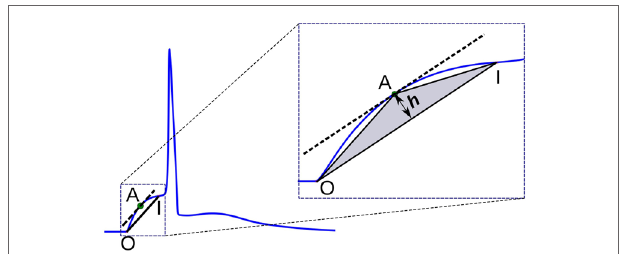
FIgURe 7 | Convexity evaluation using triangulation altitude method. O and I represent the onset and end of the foot, respectively. Point A represents the apex of the triangle at which the tangent of the foot is parallel to the base OI of the triangle. h is the altitude used as a measure of foot